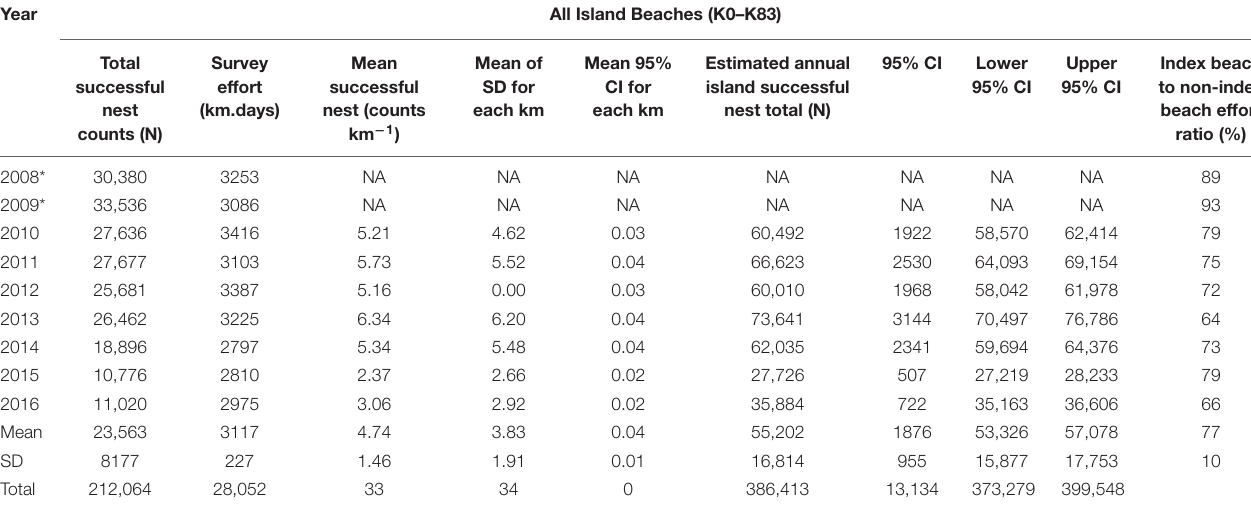
TABLE 1 | Nest count summary statistics across all nest survey beaches derived from index and non-index beaches.